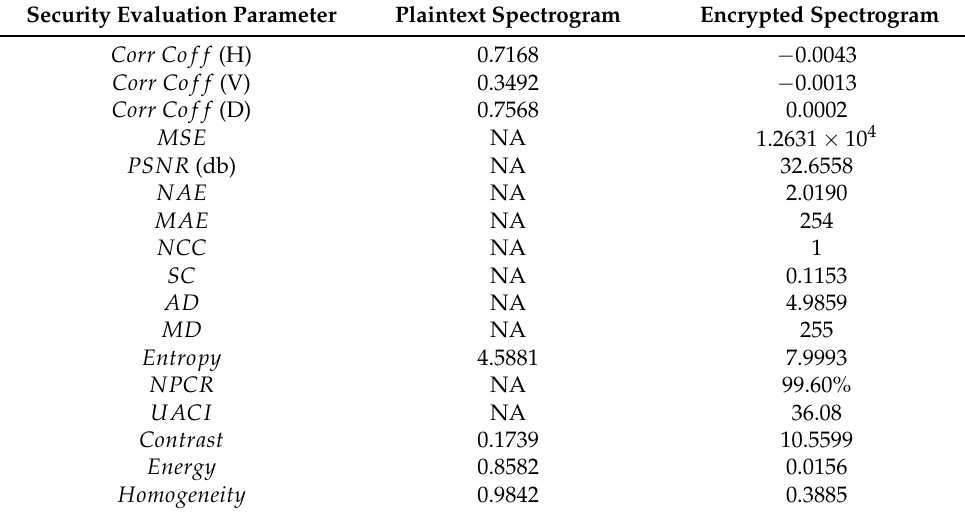
Table 5. Security analyses of the encrypted spectrogram: green channel.